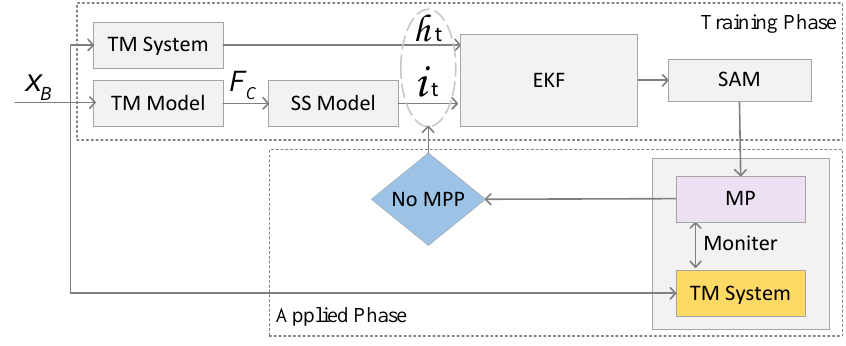
Figure 5. Process of the self-adaptive method.